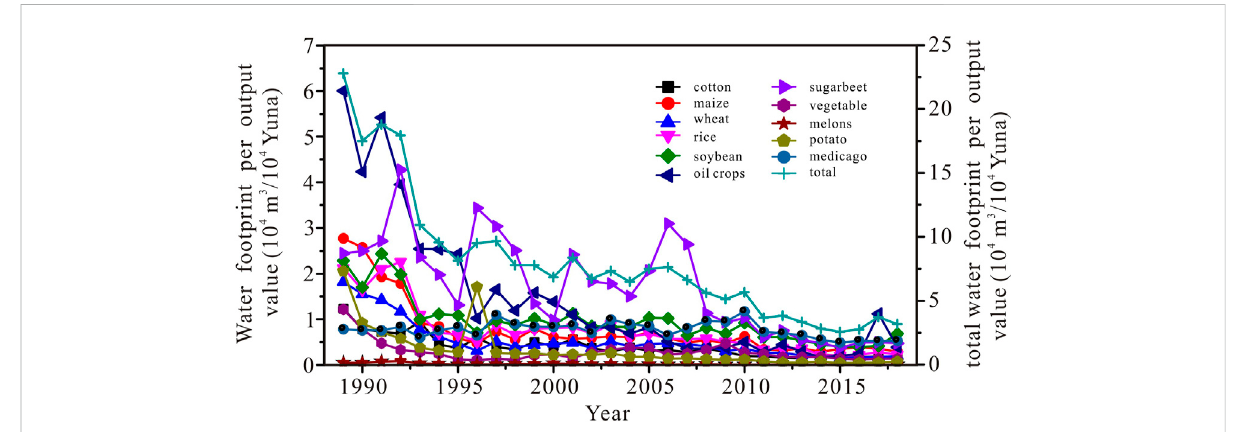
FIGURE 7 Trends of crop water footprint per output value in Xinjiang from 1989 to 2018.